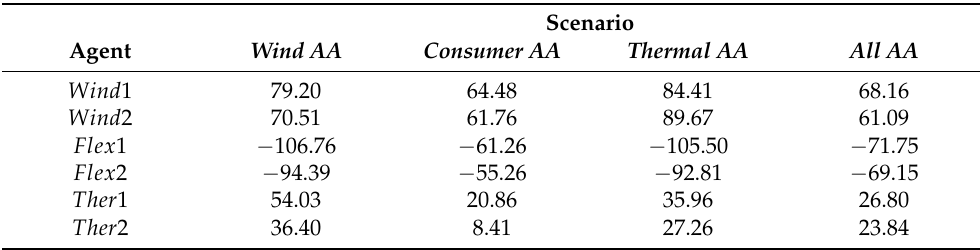
Table 2. Revenues of agents (k (cid:99) ) before imbalance settlement (incl. day-ahead) under the four investigated